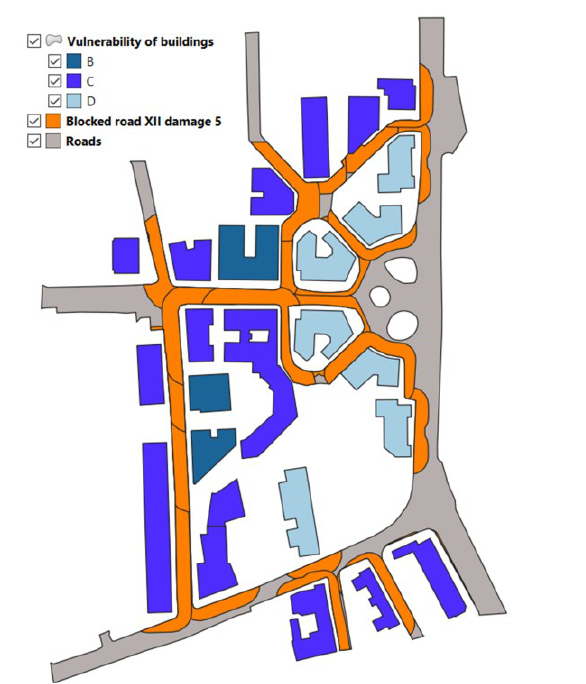
Figure 13. The scenario for intensity degree XII: clear (grey) and blocked (orange) roads.